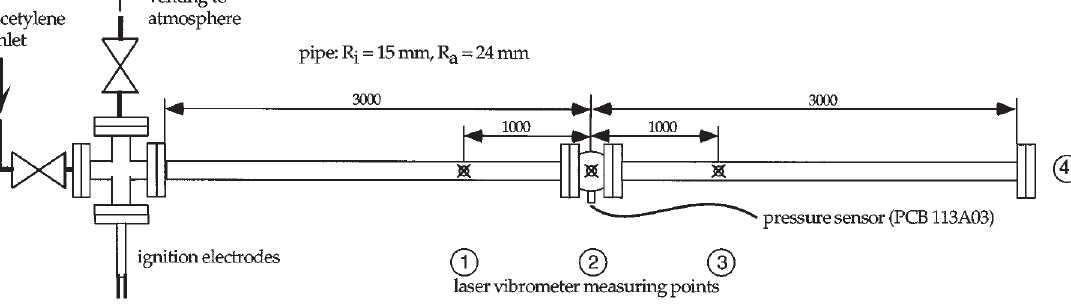
Fig. 3. Experimental setup for measuring the oscillations excited in the wall of a pipe (inner radius R i = 15 mm, outer radius R a = 24 mm, wall thickness 9 mm) by detonations of acetylene at initial pressures up to 20 bar.